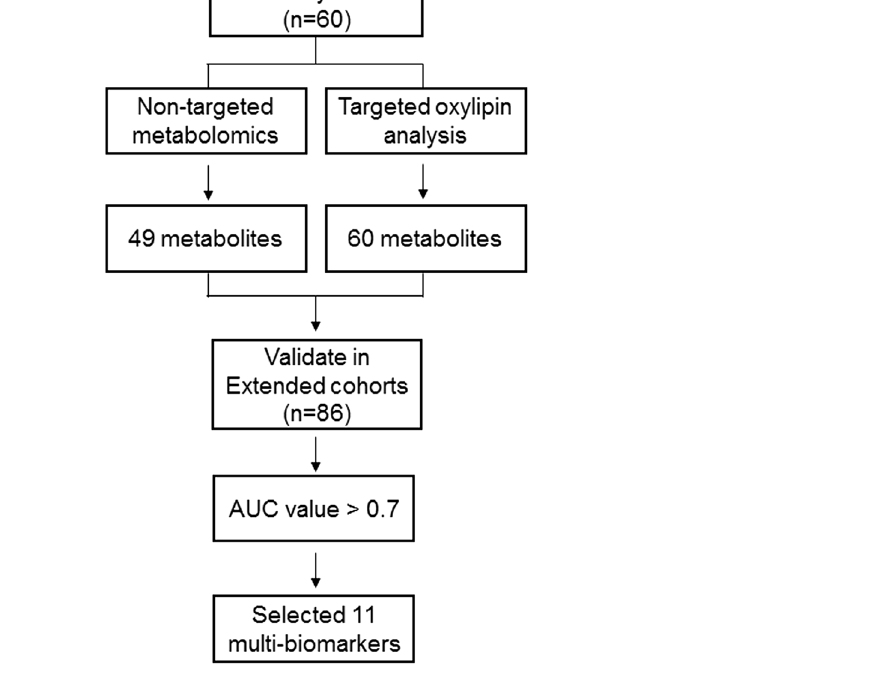
Figure 1. Schematic representation of experimental procedures used for investigating multi-biomarkers of diabetic macular edema (DME) in study